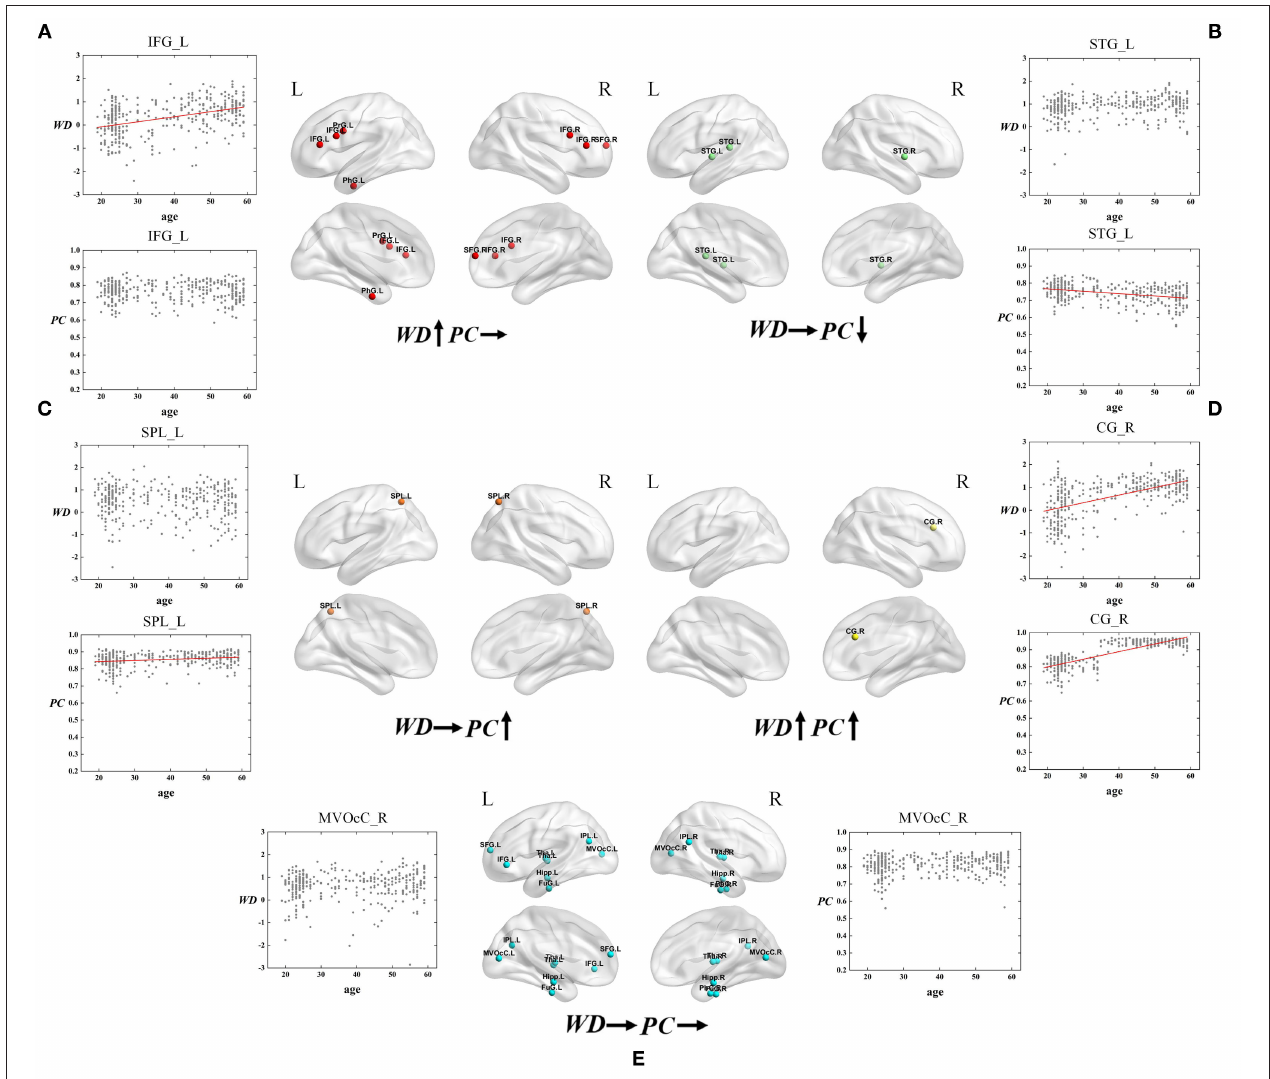
FIGURE 6 | The spatial distributions of hubs at Young - Middle age stage with (A) only WD has a positive correlation with age; (B) only PC has a negative correlation with age; (C) only PC has a positive correlation with age; (D) Both WD and PC have a positive correlation with age; (E) Both WD and PC have no correlation with age. Red lines fit the curve with statistically significant